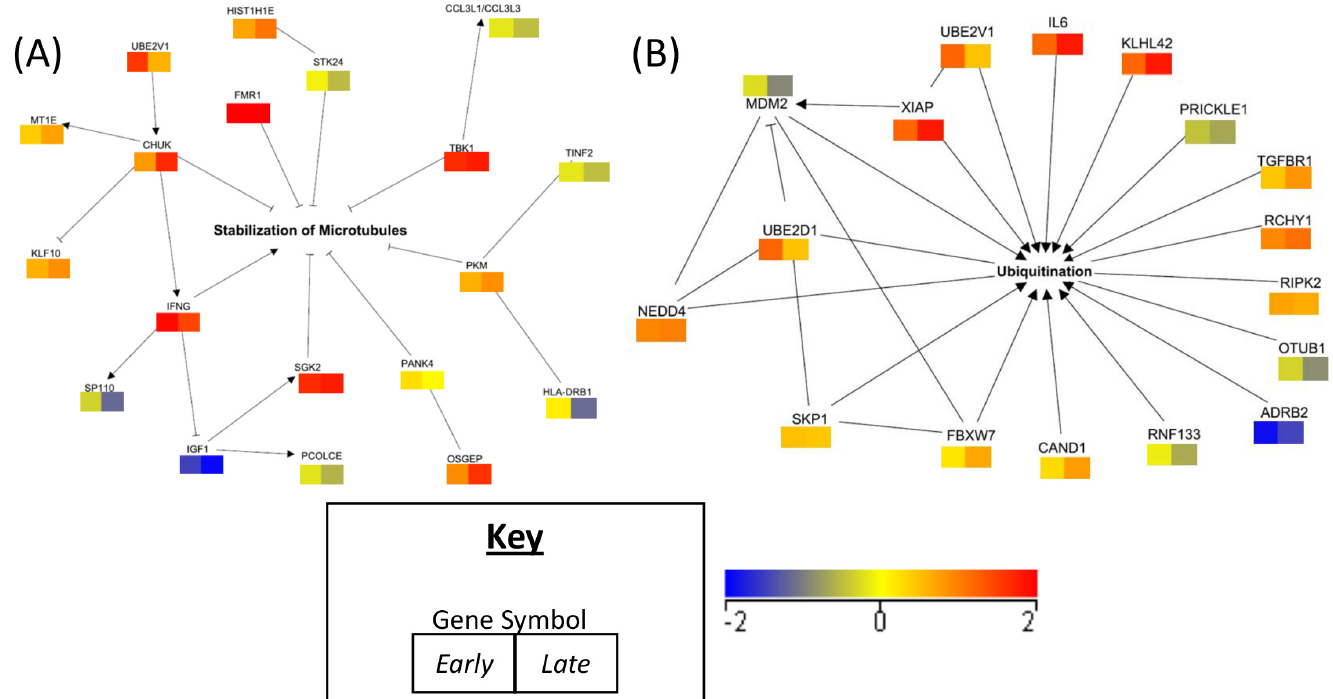
Fig 3. Networks of interest. The average fold changes of Early (45m-18h) and Late (24h-42h) time groups are presented in the right and left boxes, respectively. The color scale presented in the bottom right corner shows the gradient of fold change with red upregulated, blue downregulated and yellow no change in gene expressions. (A) Network of Stabilization of Microtubules. (B) Network profile of Ubiquitination.